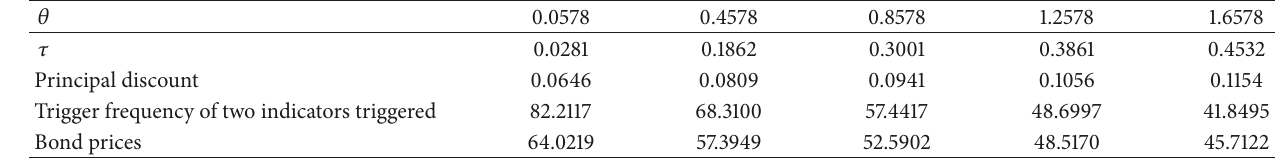
Table 6: Effect of dependence 𝜃